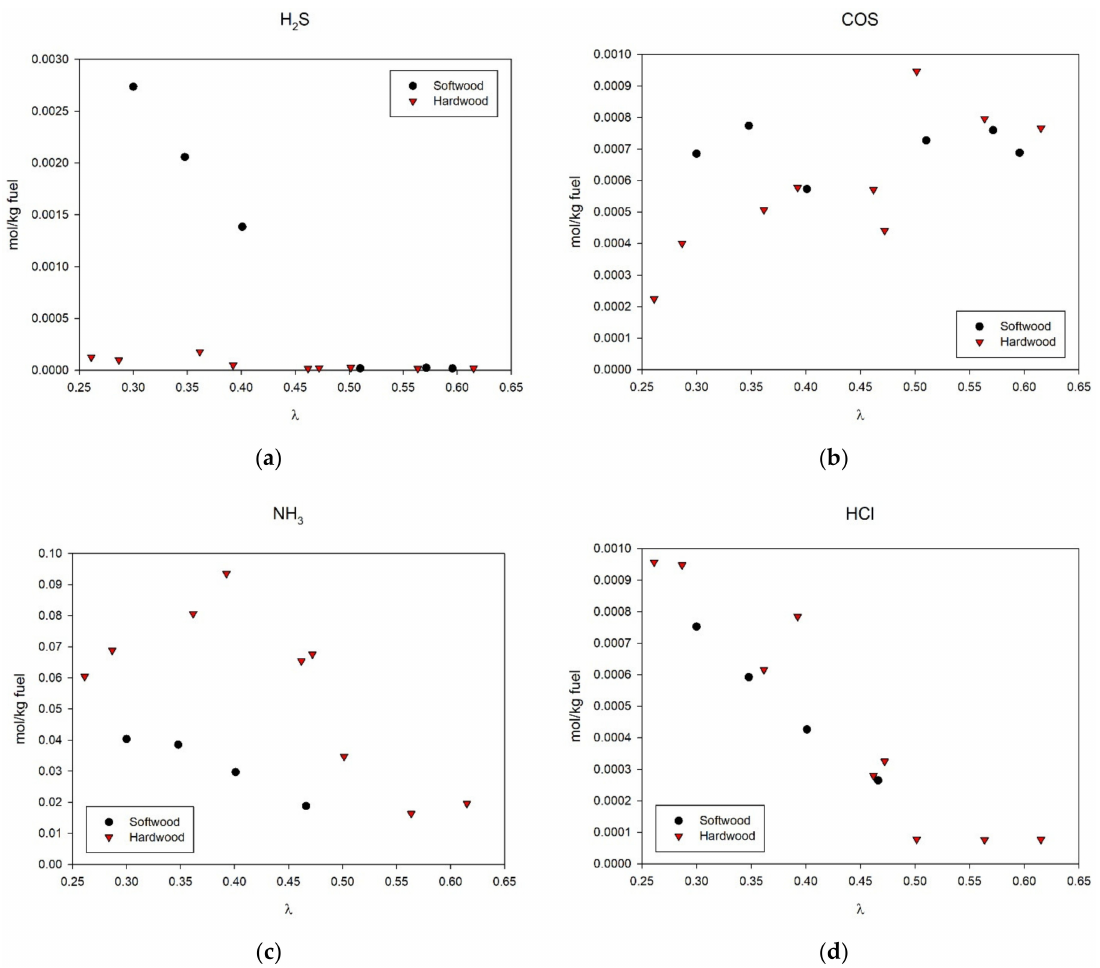
Figure 7. Gas yields (mol/kg fuel) of the trace syngas components ( a ) H 2 S, ( b ) COS, ( c ) NH 3 , and ( d ) HCl as functions of λ